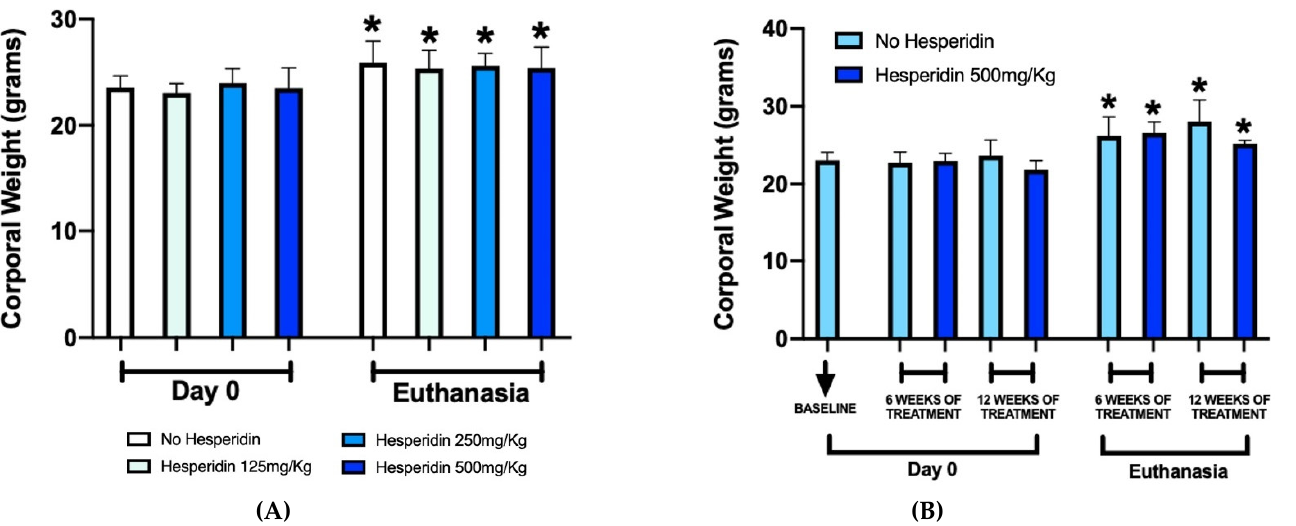
Figure 1. Corporal weight of mice before experiments (Day 0) and at euthanasia. The graphs show a uniform increase in corporal weight in both periodontal disease ( A ) and femur ( B ) mouse models at euthanasia compared to Day 0. * p < 0.05 compared to the respective group at Day 0.